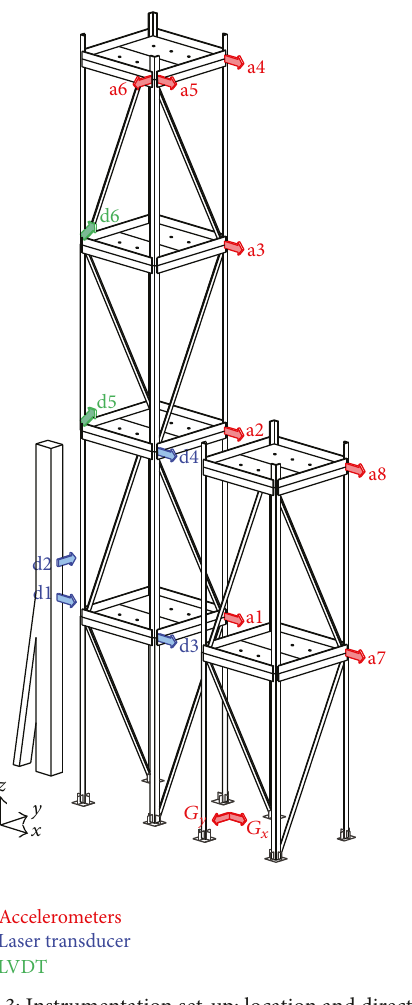
Figure 3: Instrumentation set-up: location and direction.